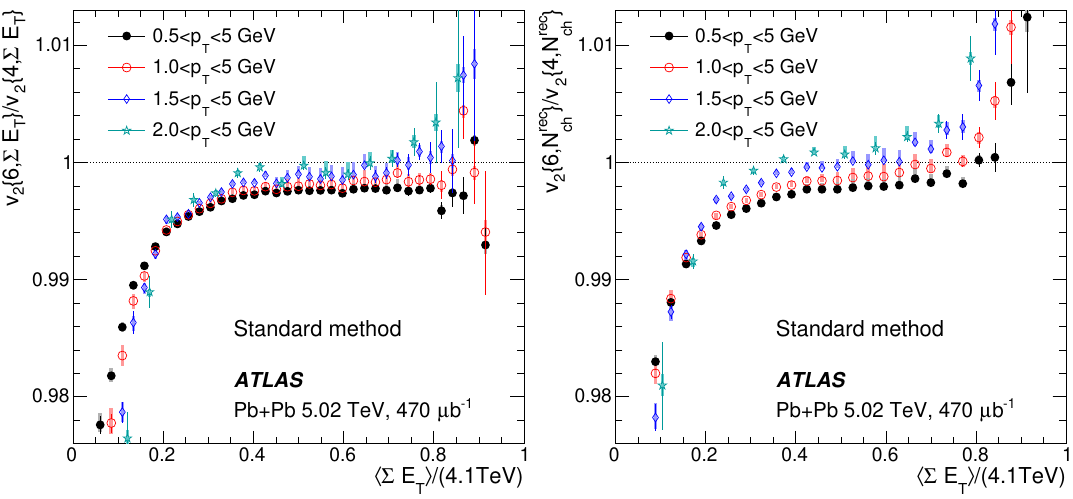
Figure 18 . The h (cid:6) E T i dependence of cumulant ratio v 2 f 6 ; (cid:6) E T g =v 2 f 4 ; (cid:6) E T g (left panel) and v 2 f 6 ; N rec g =v 2 f 4 ; N rec g (right panel) for charged particles in four p T ranges. The error bars and ch ch shaded boxes represent the statistical and systematic uncertainties, respectively. Unity is indicated by a dotted line.